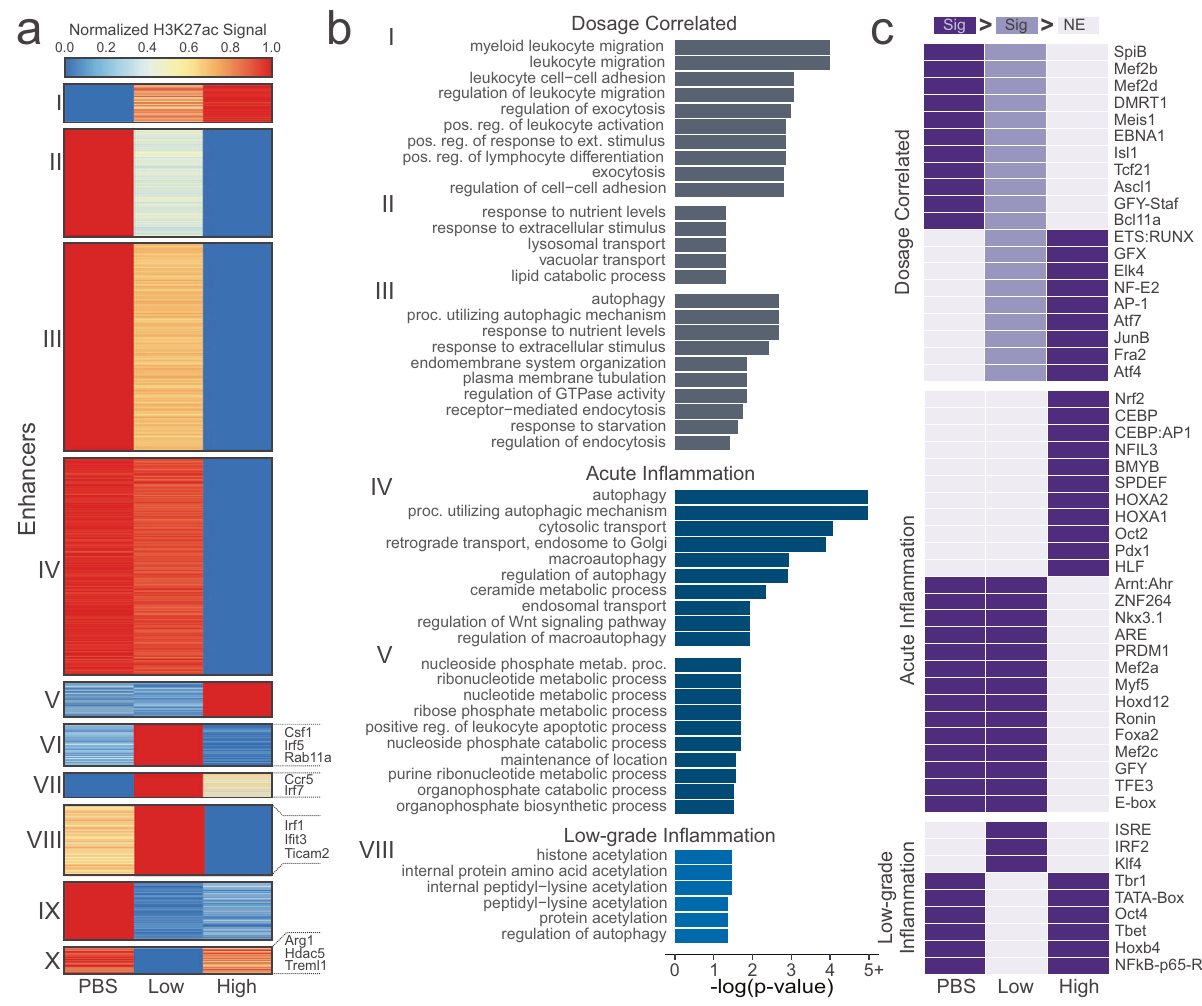
Fig. 3 Effect of LPS dosage on enhancers. a K-means clustering of enhancers present in PBS, Low-dose, or High-dose samples. b Signi fi cant (FDR < 0.05) Gene Ontology biological process gene sets for clusters from ( a ). c Motifs that are signi fi cantly enriched ( p < 1 × 10 − 6 ) in at least one condition compared to another. Dark purple cells denote that motif is signi fi cantly enriched ( p < 1 × 10 − 6 ) in that experimental condition in relation to any light purple or gray cells. Light purple cells are used as a middle ground such that dark purple is more signi fi cant than light purple, and light purple is more signi fi cant than gray. Non-enriched gray cells (NE) do not have a p -value cutoff, as they refer to the conditions with the lowest enrichment of that